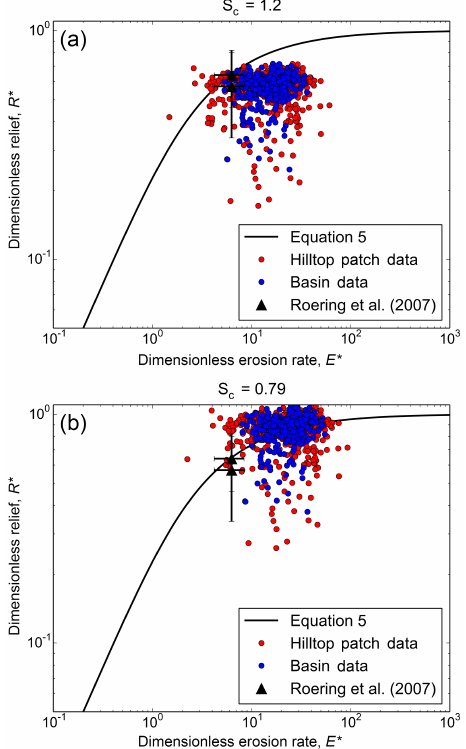
Figure 4. Hilltop patch and basin average data for the Oregon Coast Range plotted using a critical gradient of 1.2 (a) and 0.8 (b) along- side data from Roering et al. (2007) for the same location. Error bars are the standard